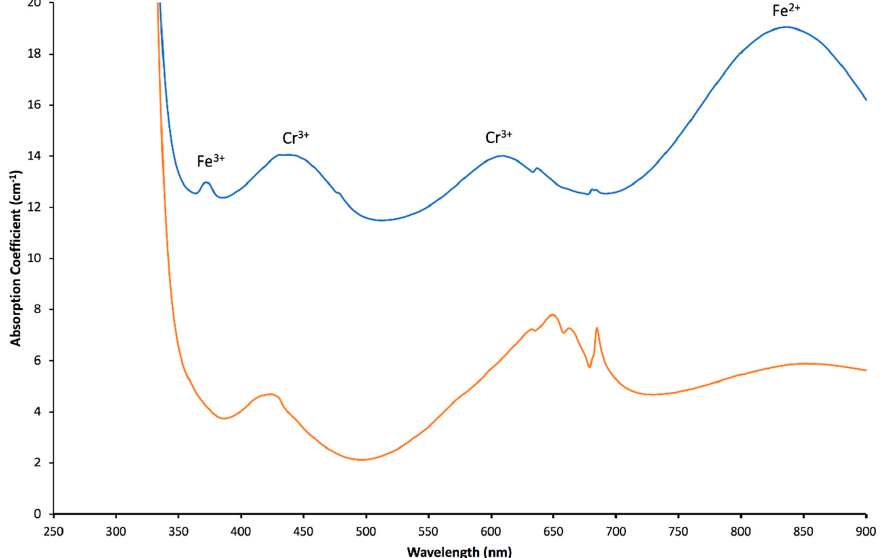
Figure 15. UV-Vis polarized spectra of an emerald from Zambia. The light blue and orange lines are for the o-ray and e-ray spectra, respectively. The upper spectrum has been vertically offset for clarity.